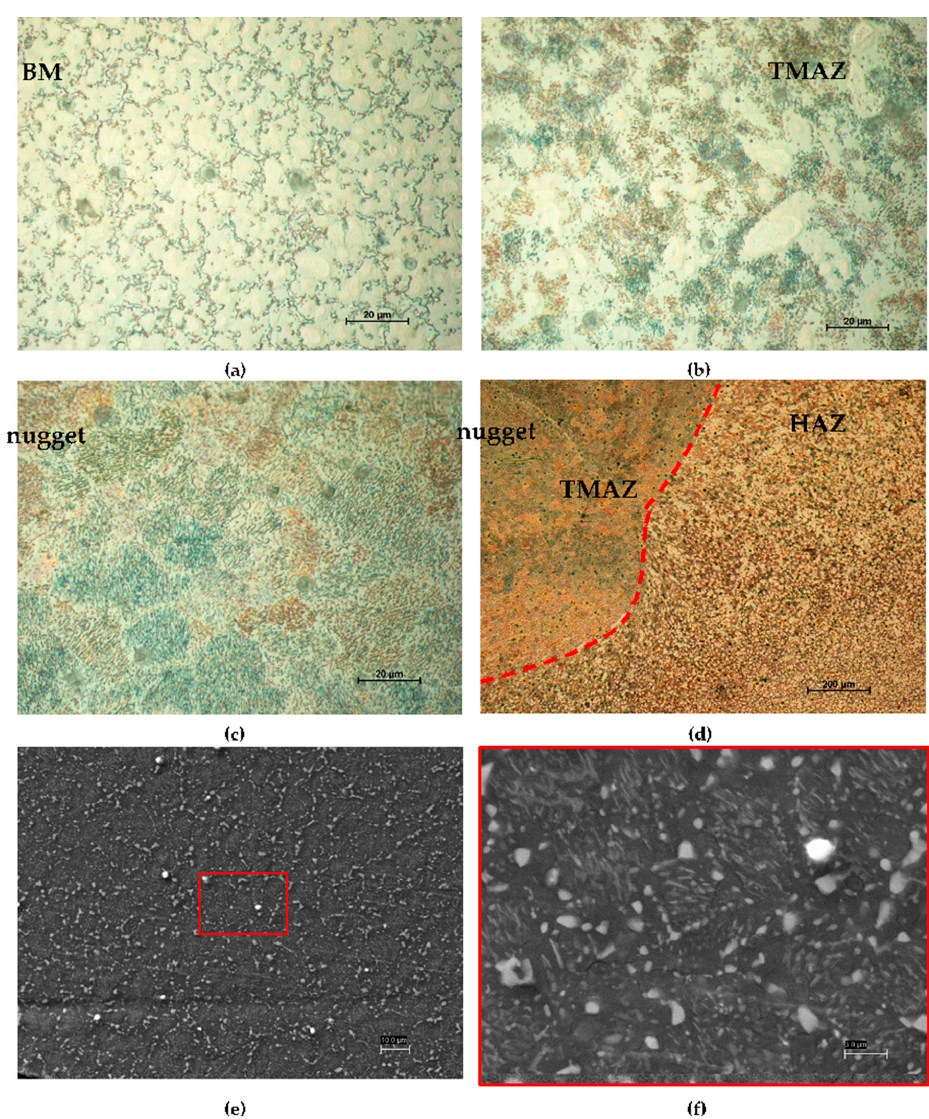
Figure 6 . Microstructure of the sample FSPed at 2500 rpm-30 mm/min and aged at 300 °C for 6 h showing precipitate distributions in the characteristic zones. Optical microscopy of ( a ) base material (BM) zone, ( b ) thermomechanical a ff ected zones (TMAZ), ( c ) nugget area and ( d ) lower magnification picture showing the narrow thermomechanical a ff ected zone (TMAZ) separating the nugget and the HAZ. SEM pictures of the nugget at low ( e ) and high magnification ( f ) showing